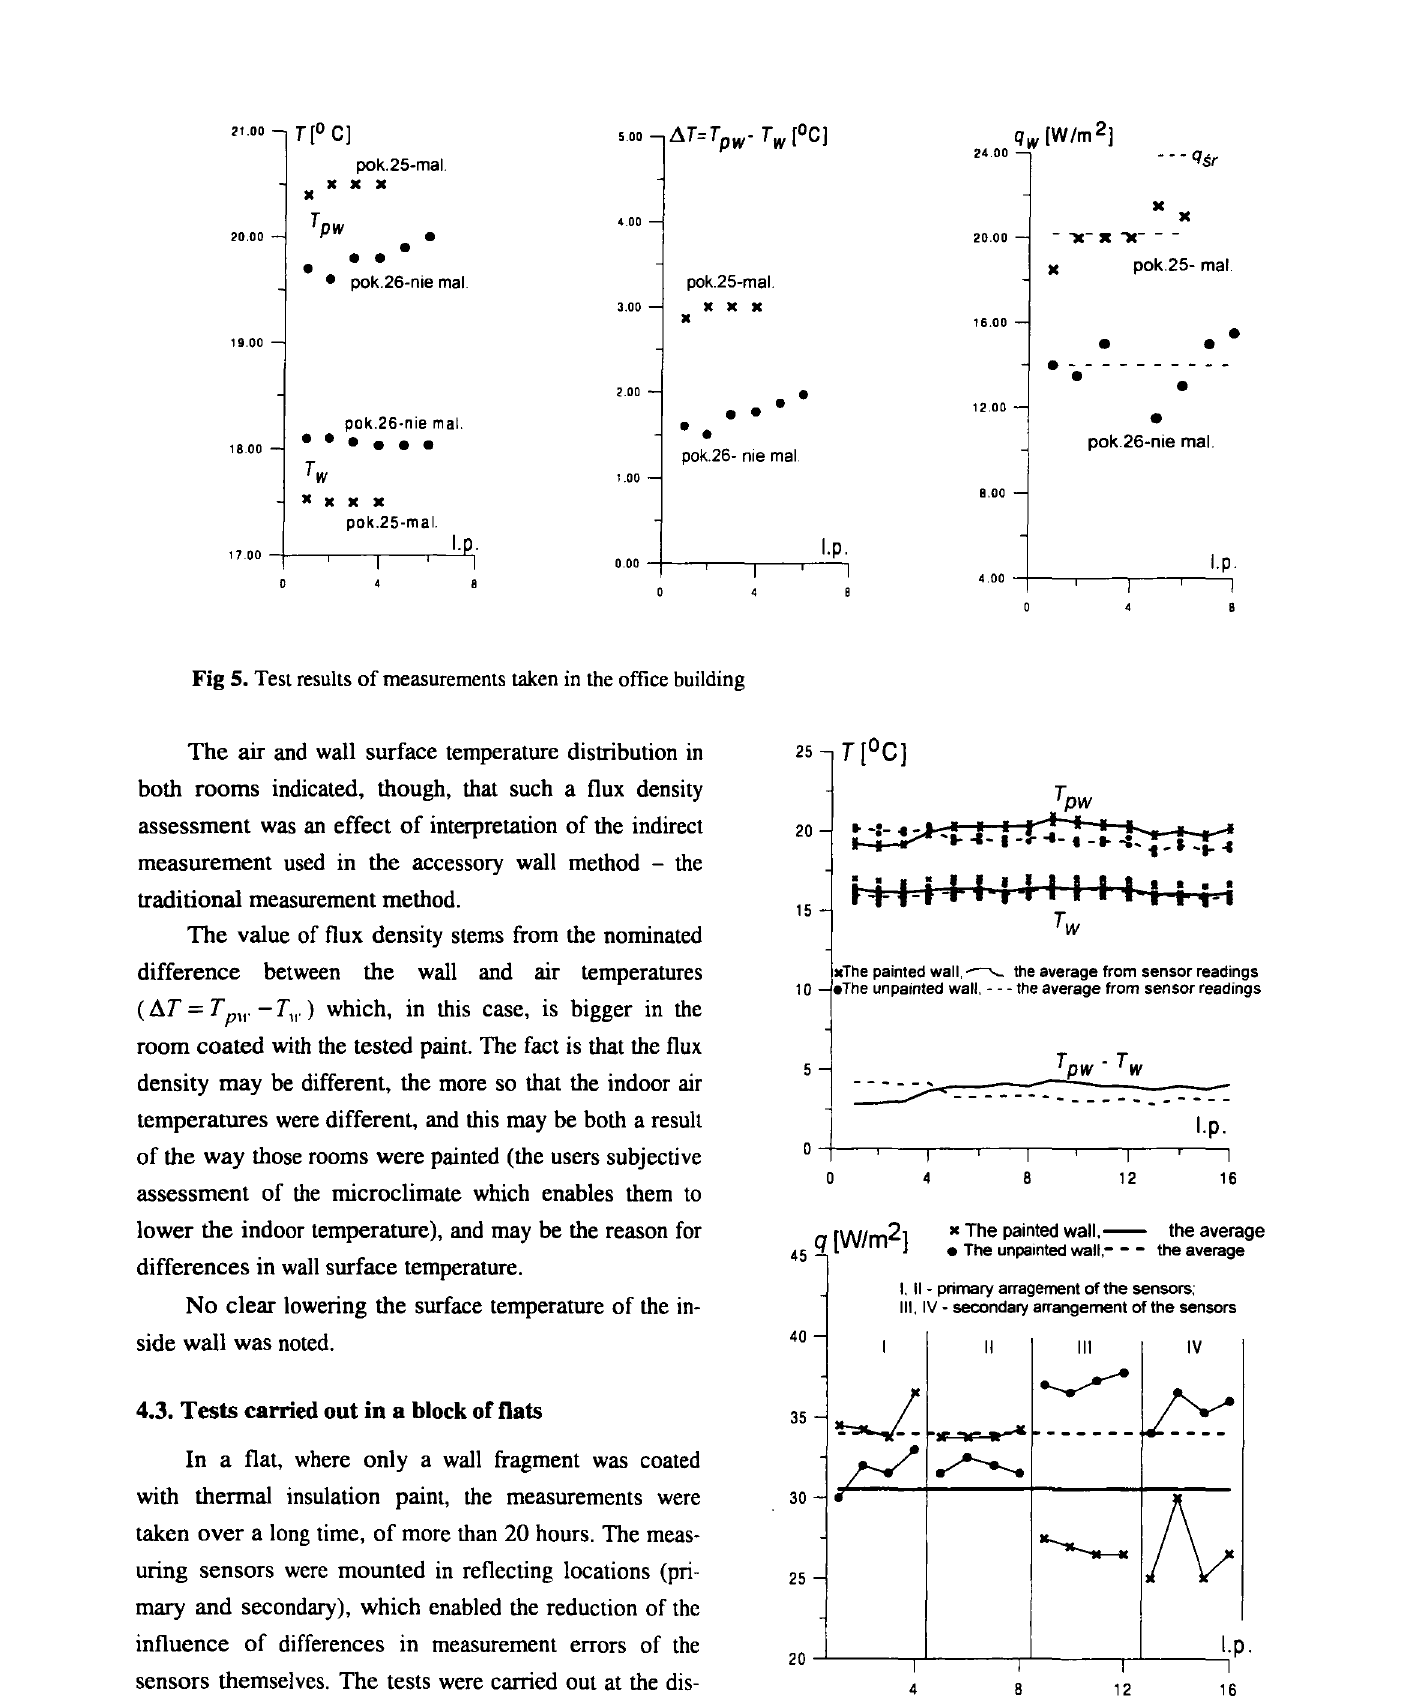
Fig 6. Results of measurements taken in a